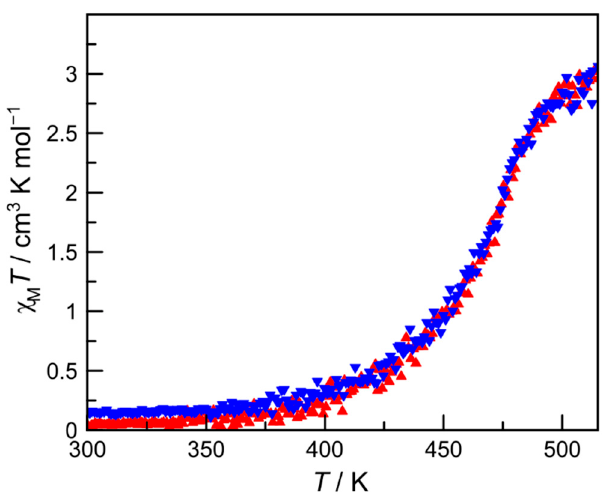
Figure 3. The magnetic behavior of 1 in the form of χ M T vs. T plots. Complex 1 was warmed from 300 to 515 K (filled triangles; red) and then cooled from 515 to 300 K (filled inverted triangles; blue) at a sweep rate of 1 K min –1 .